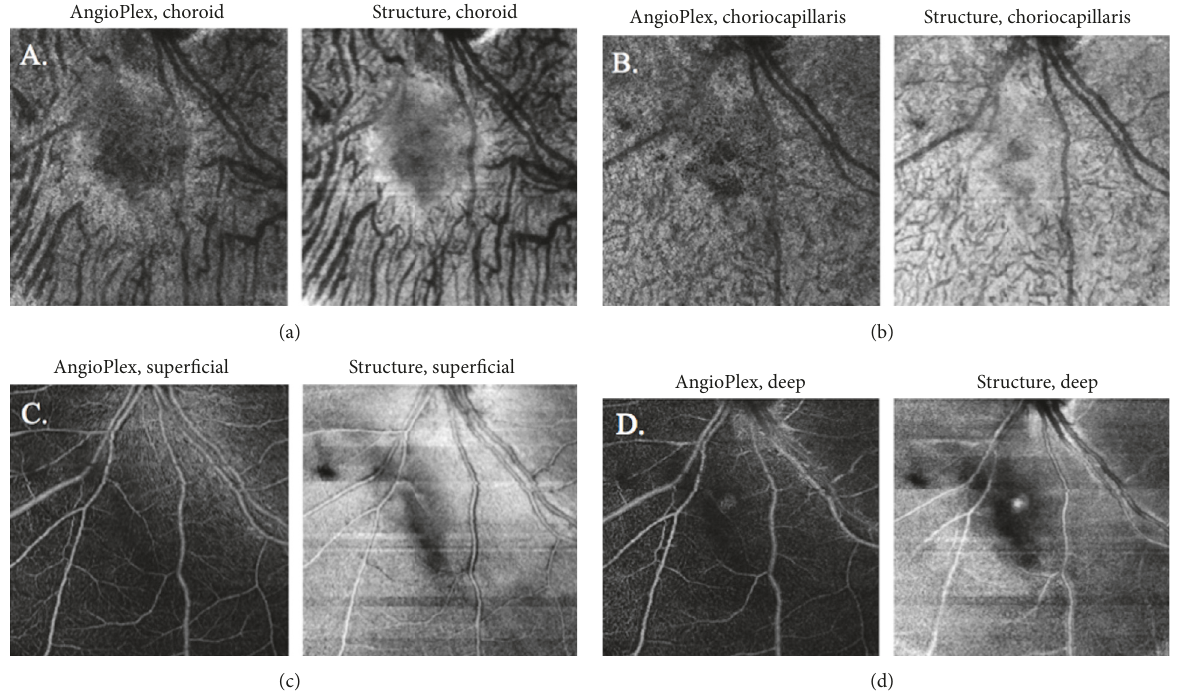
Figure 2: AngioPlex OCT-A 6 mm × 6mm. (a) Choroidal plexus layer showing a decreased vascular flow signal. (b) Choriocapillary plexus layer showing a decreased vascular flow signal. (c) Superficial retinal plexus layer showing a subtle decreased vascular flow signal. (d) Deep retinal plexus layer showing a subtle decreased vascular flow